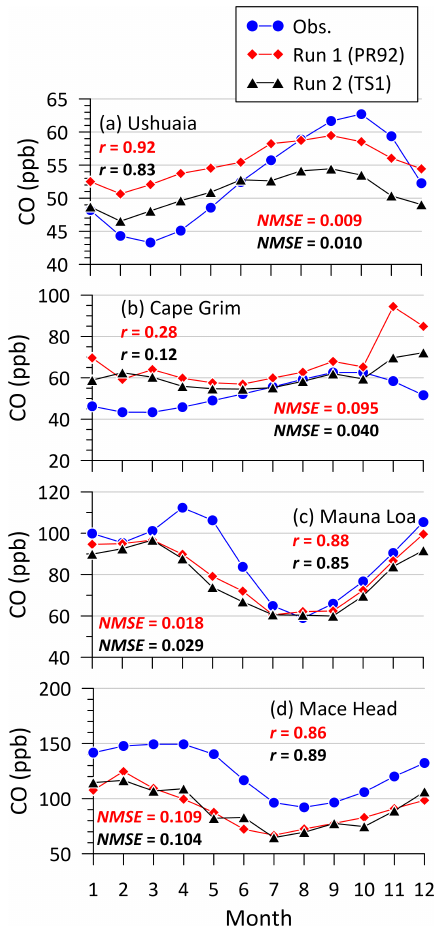
Figure 19. Comparison of the modelled monthly averaged CO con- centrations (ppbv) with observations at four oceanic/coastal ground stations for the year 2006. The two model runs are with the default PR92 parameterisations (Run 1) and new lightning flash-rate pa- rameterisations (Run 2). The values of r and NMSE are also